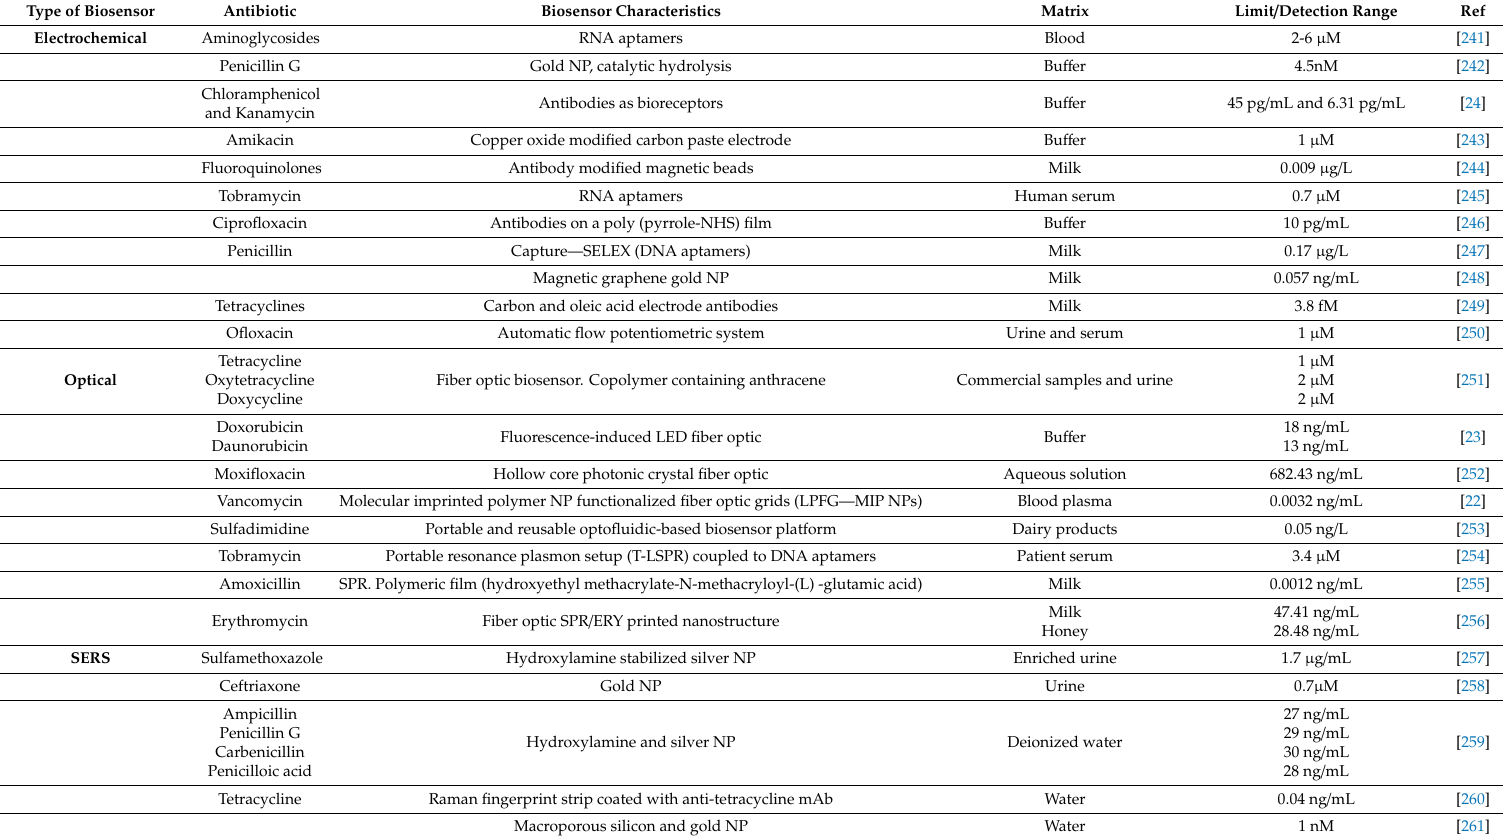
Table 3. Biosensors used in the measurement of